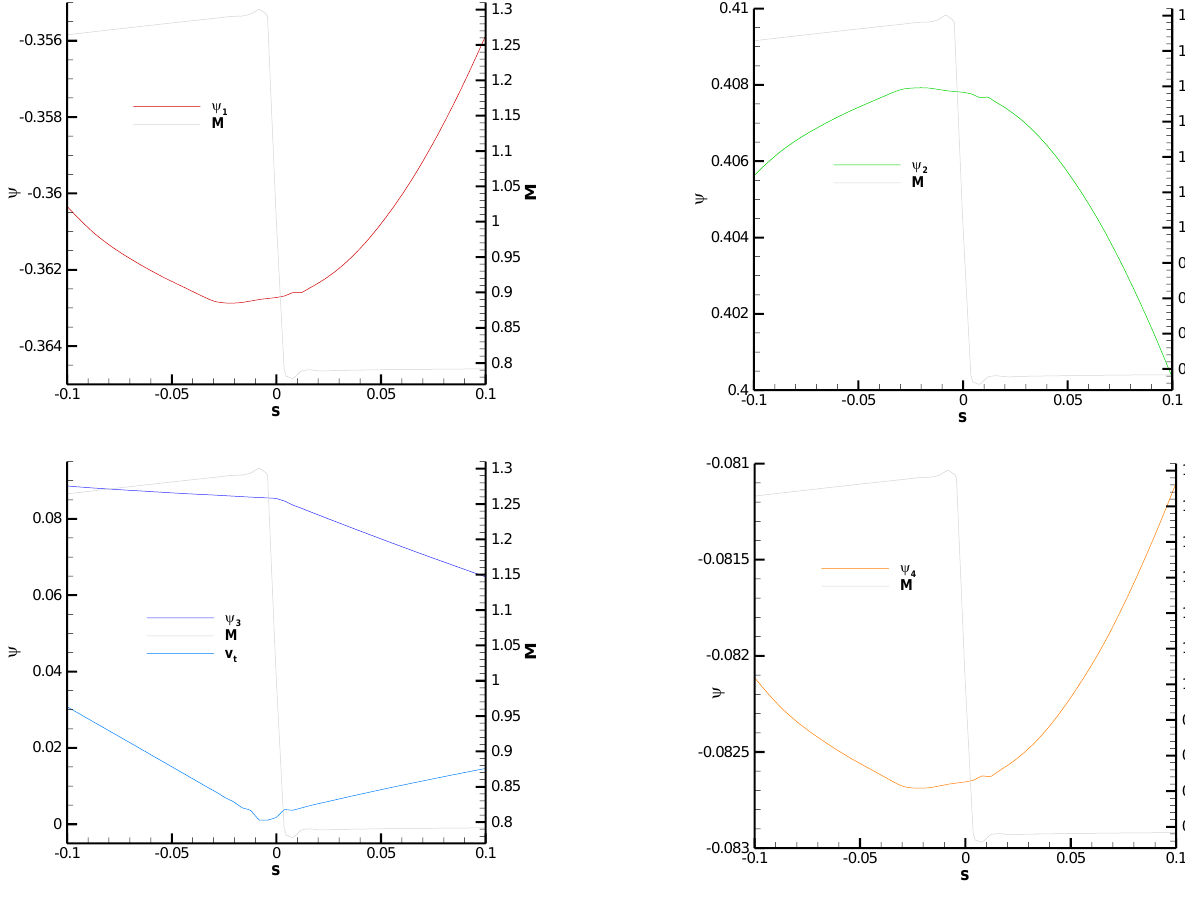
Figure 16. Adjoint variables along the cutting line indicated in Figure 15. Mach number and tangential velocity are also shown for reference.